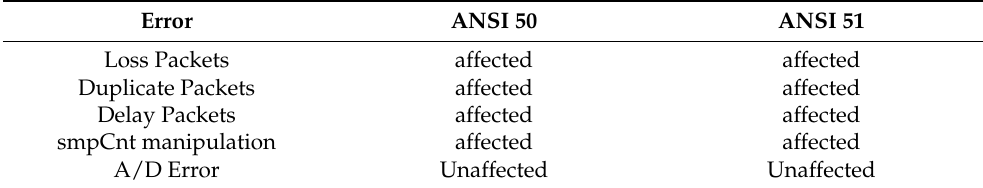
Table 5. Comparison between protections and